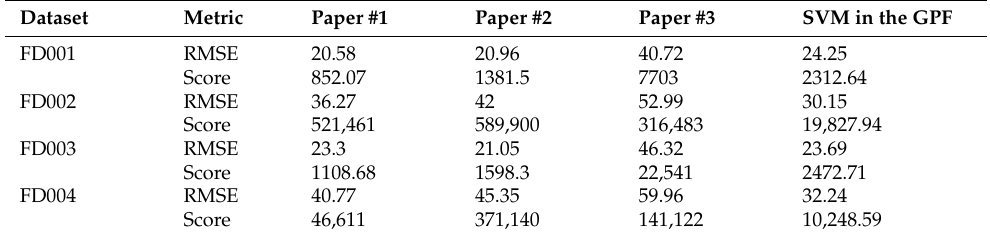
Table 8. Support vector machine RMSE and score on the three papers of literature and using the GPF.